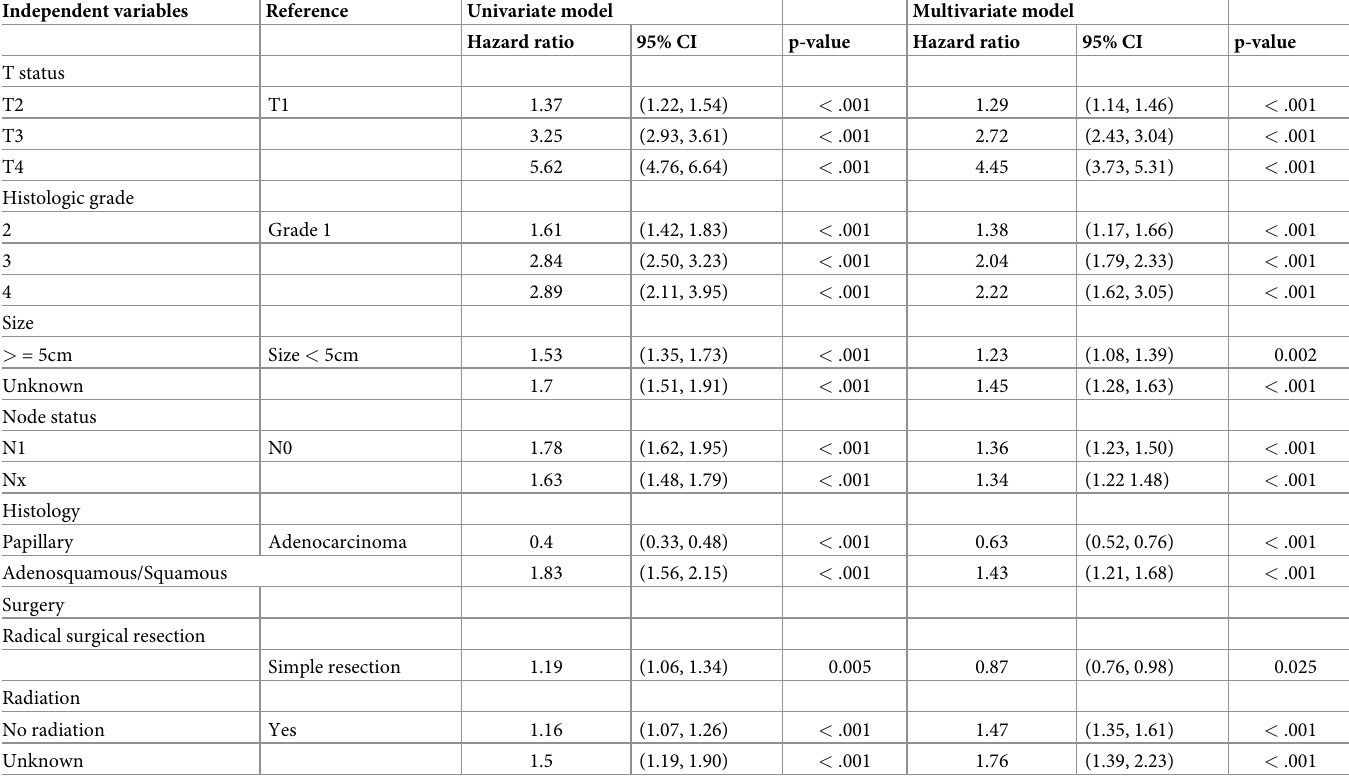
Table 3. Univariate and multivariate analysis model for disease specific survival.